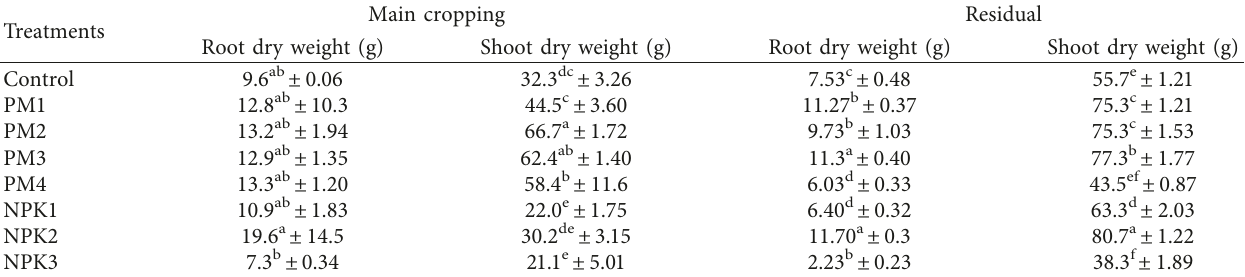
Table 6: Effect of different rates of chicken manure and NPK fertilizers on dry matter partitioning by sunflowers. Main Treatments